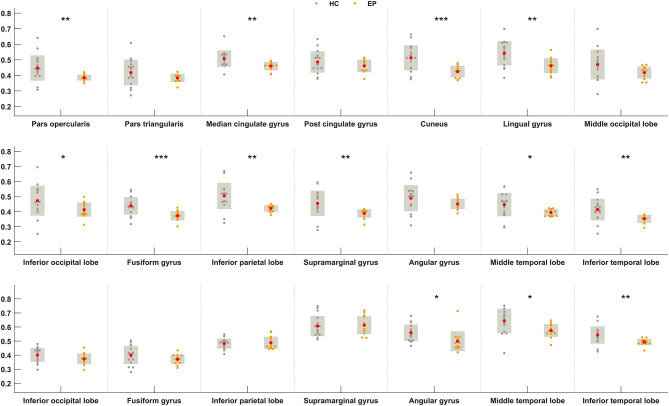
Between-group differences in FDG uptake for regions showing greater metabolic covariance with the insula. Orange and gray circles denote FDG uptake values in individuals with insular epilepsy and healthy individuals, respectively. Solid red circles denote the mean FDG uptake. HC, Healthy group; EP, Epileptic group. *P < 0.05, **P < 0.01, ***P < 0.001.